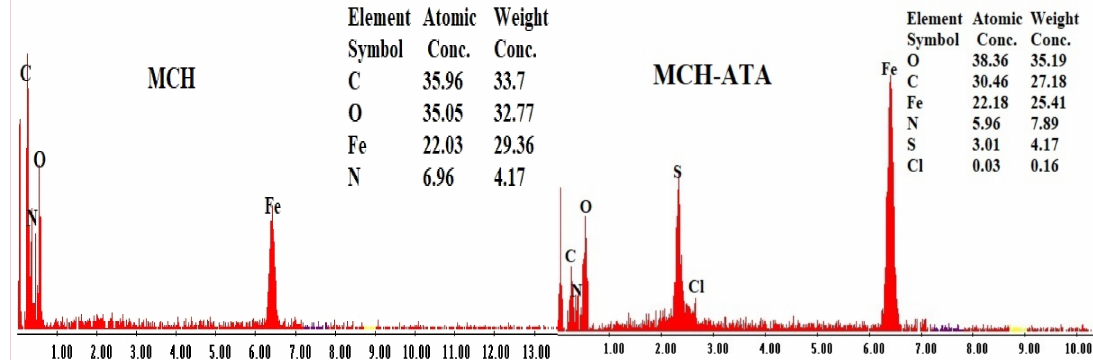
Figure 4. SEM-EDX analysis of MCH and MCH-ATA sorbent.